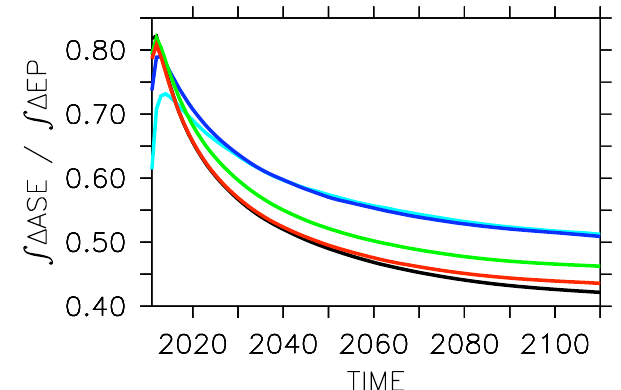
Fig. 11. Ratio of cumulative global OIF-induced air-sea CO 2 flux to cumulative global OIF-induced export production for simulated continuous OIF applied to surface waters everywhere south of 30 ◦ S (black), surface waters denser than σ 0 = 26 . 4 (red), denser than σ 0 = 26 . 8 (green), σ 0 = 27 . 2 (blue) and σ 0 = 27 . 4